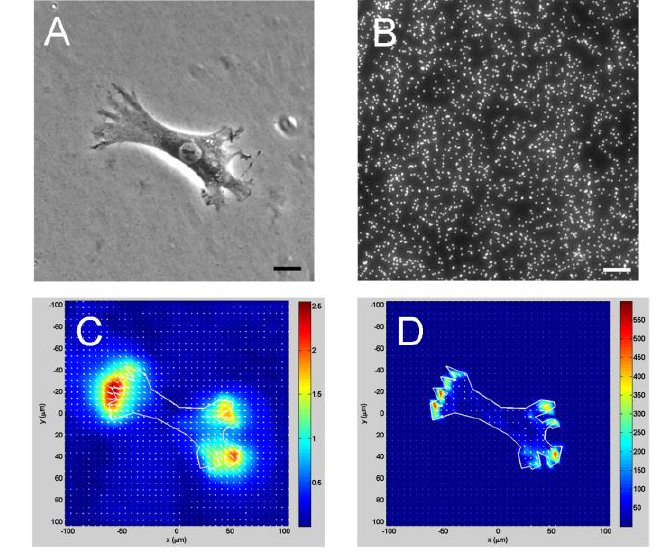
Figure 5. An illustration of CTFM procedures with an application example. A cell resides on an elastic substrate typically made of polyacrylamide gel A . The cell exerts CTFs on the underlying gel and so deforms it. The gel deformation is measured by displacements of fluorescent beads embedded in the gel B . By imaging analysis with a set of computer algorithms, a displacement map can be obtained C . From the displacements, a CTF map that represents CTF distribution beneath the cell can be obtained by solving an inverse problem ( i.e. , “converting” displacements to CTFs) using elasticity theory or finite element method D